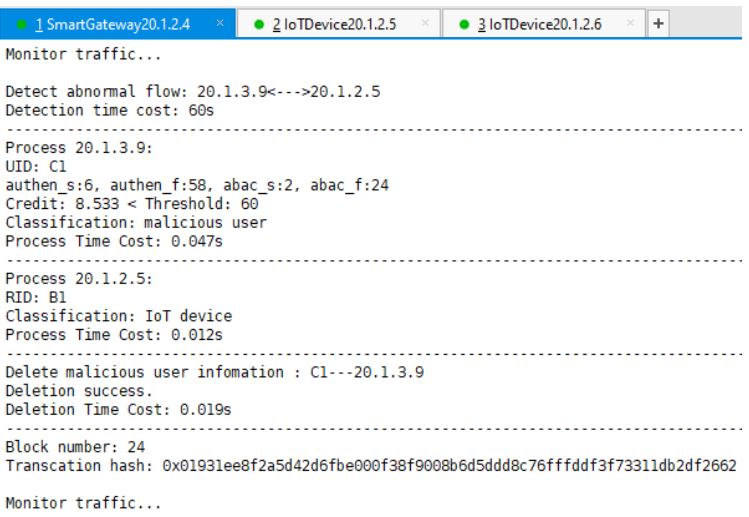
Figure 13. SG B performs the security feedback process.